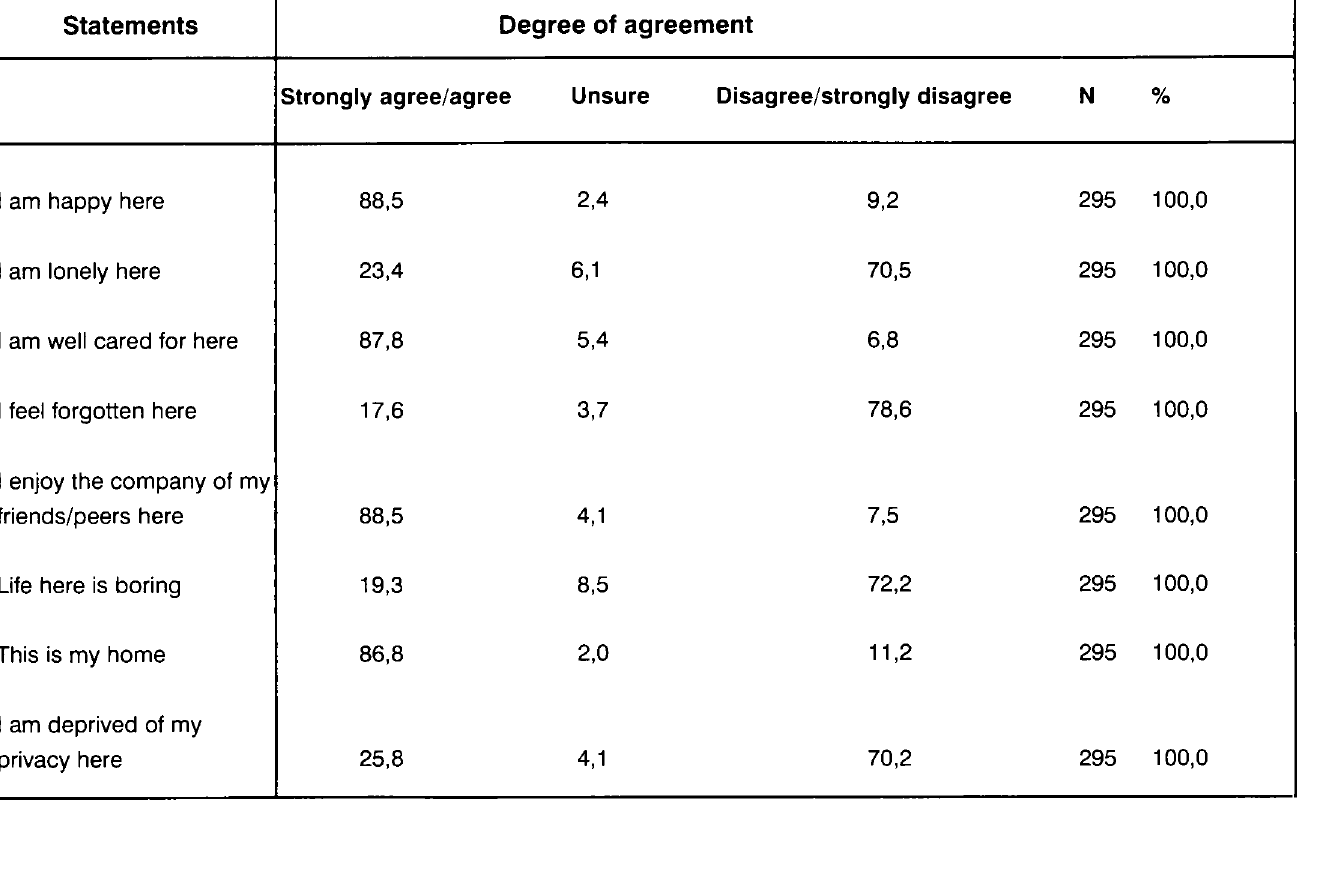
TABLE 6: Indicators of respondents’ adaptation to the old-age home environment